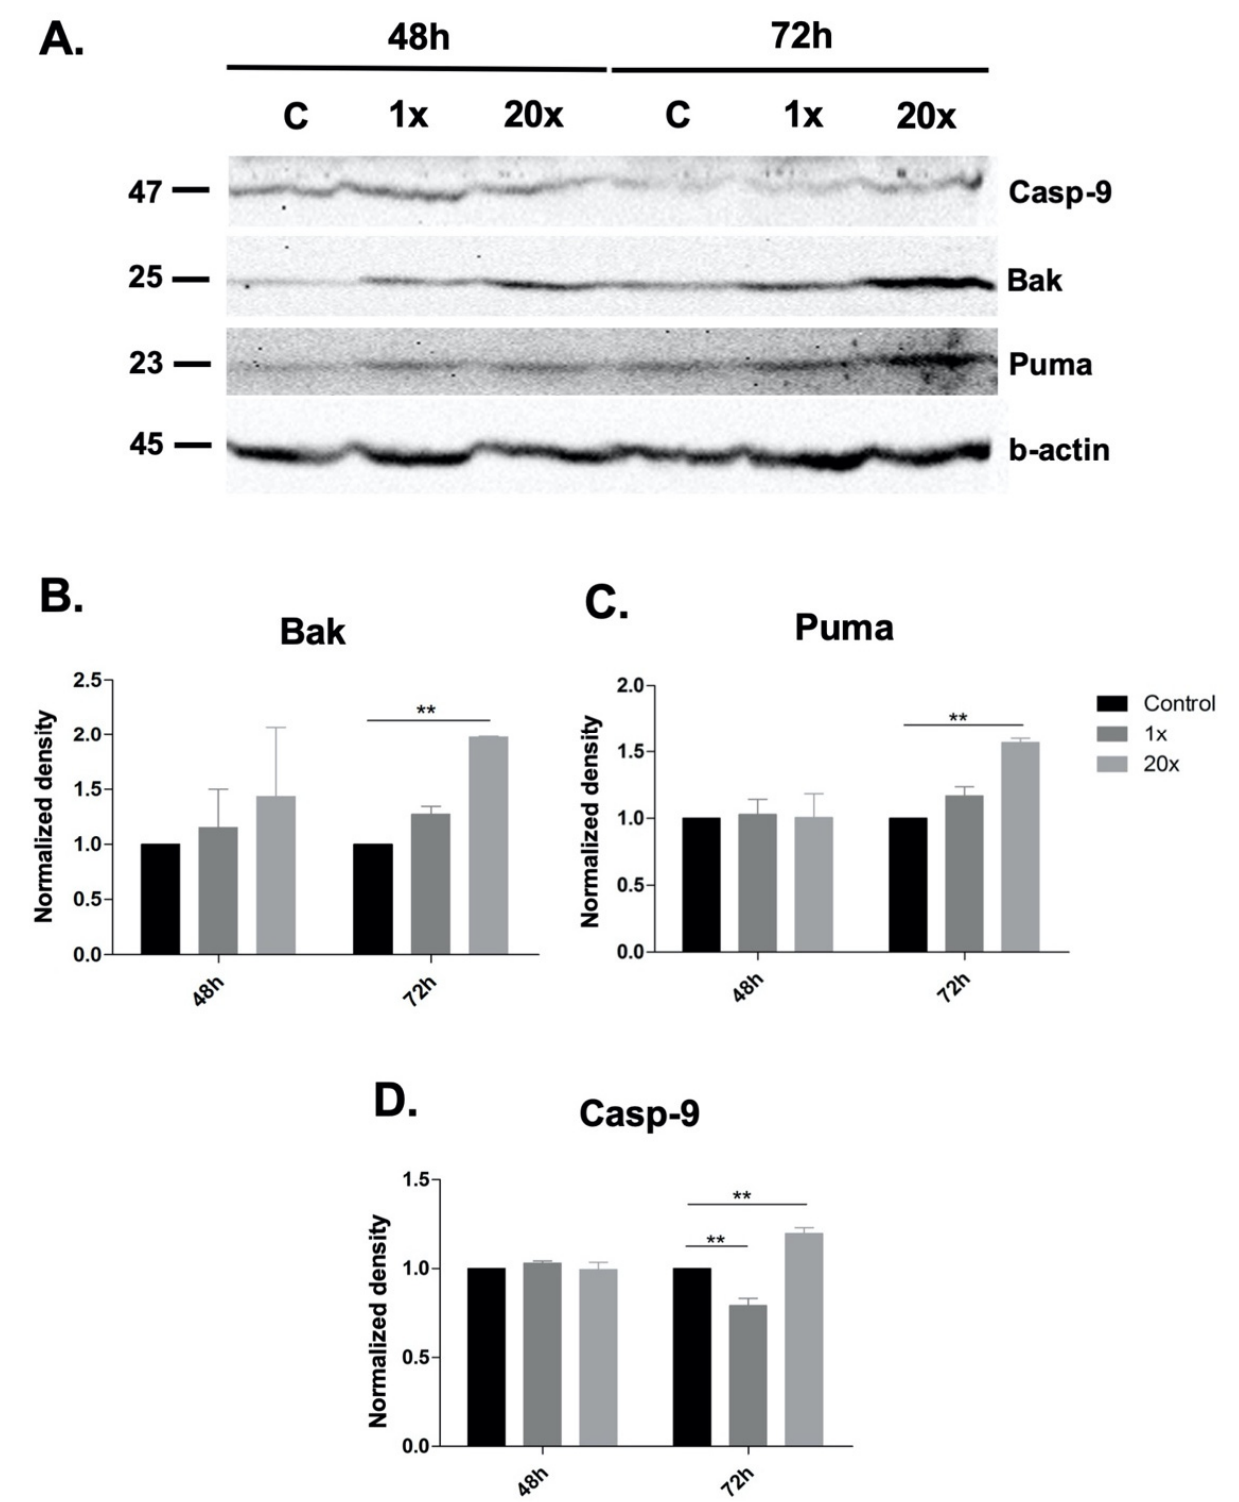
Figure 3. Western blot analysis of apoptotic proteins in methyl-donor-treated Panc-1 cells. Pro- apoptotic Bak, Puma and Caspase-9 were significantly increased in Panc-1 cells after 72 h of 20 × methyl-donor treatment ( A – D ). Each bar represents the average normalized density from at least 3 repeats ± SD. Statistical significances plotted as **: p < 0.01. 1 × and 20 × : concentration of methyl